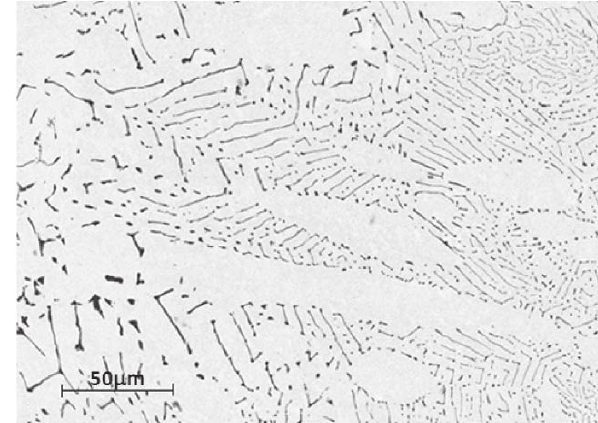
Fig. 11: SEM-BSE image showing TiC particles (thin and longish) in the alloy droplet from experiment 10 FeNi9 (10 min)